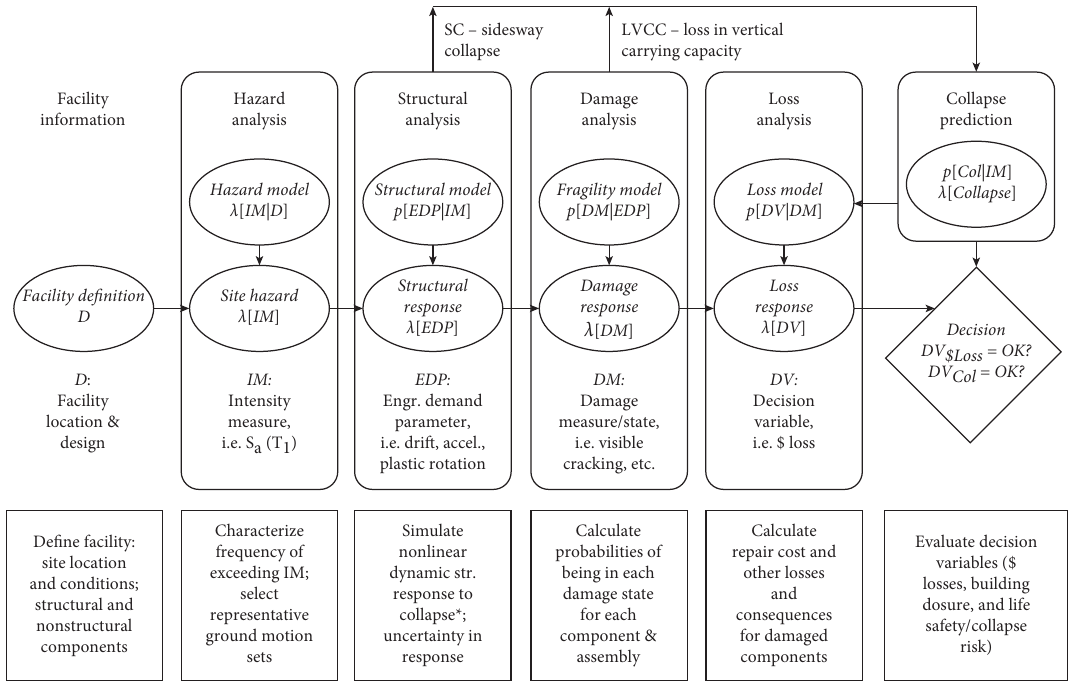
Figure 4: Provided PBEE framework for design based on probabilistic performance and minimizing the probability of collapse